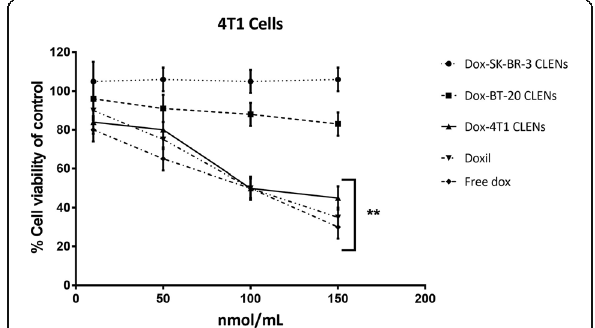
Fig. 6 Cytotoxicity of doxorubicin-loaded CLENs. 4 T1 cells were seeded at 1 X 10 4 per ml in a 48-well plate. Cells were exposed to different concentrations of doxorubicin-loaded CLENs (4 T1, BT-20, and SKBR-3). SRB assay was used to determine percent of cell